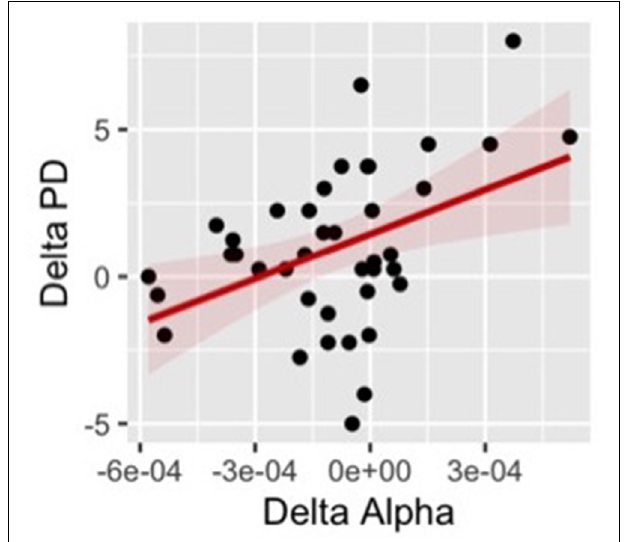
FIGURE 9 | Positive correlation between changes in proprioceptive drift and alpha